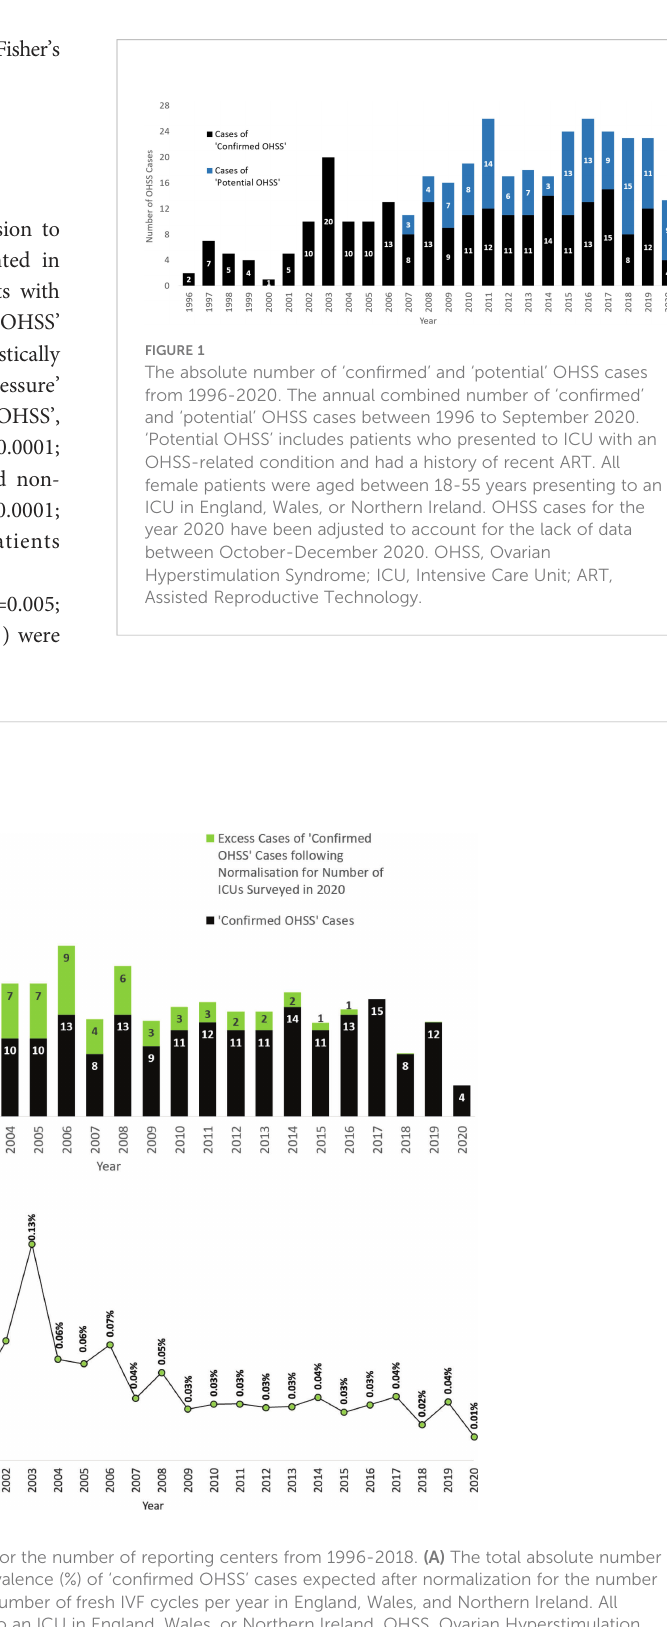
FIGURE 2 The rate of ‘ con fi rmed OHSS ’ cases following normalization for the number of reporting centers from 1996-2018. (A) The total absolute number of ‘ con fi rmed OHSS ’ cases before normalization. (B) The prevalence (%) of ‘ con fi rmed OHSS ’ cases expected after normalization for the number of ICUs surveyed in 2020, expressed as a proportion of the number of fresh IVF cycles per year in England, Wales, and Northern Ireland. All female patients were aged between 18-55 years presenting to an ICU in England, Wales, or Northern Ireland. OHSS, Ovarian Hyperstimulation Syndrome; ICU, Intensive Care Unit; IVF, In Vitro